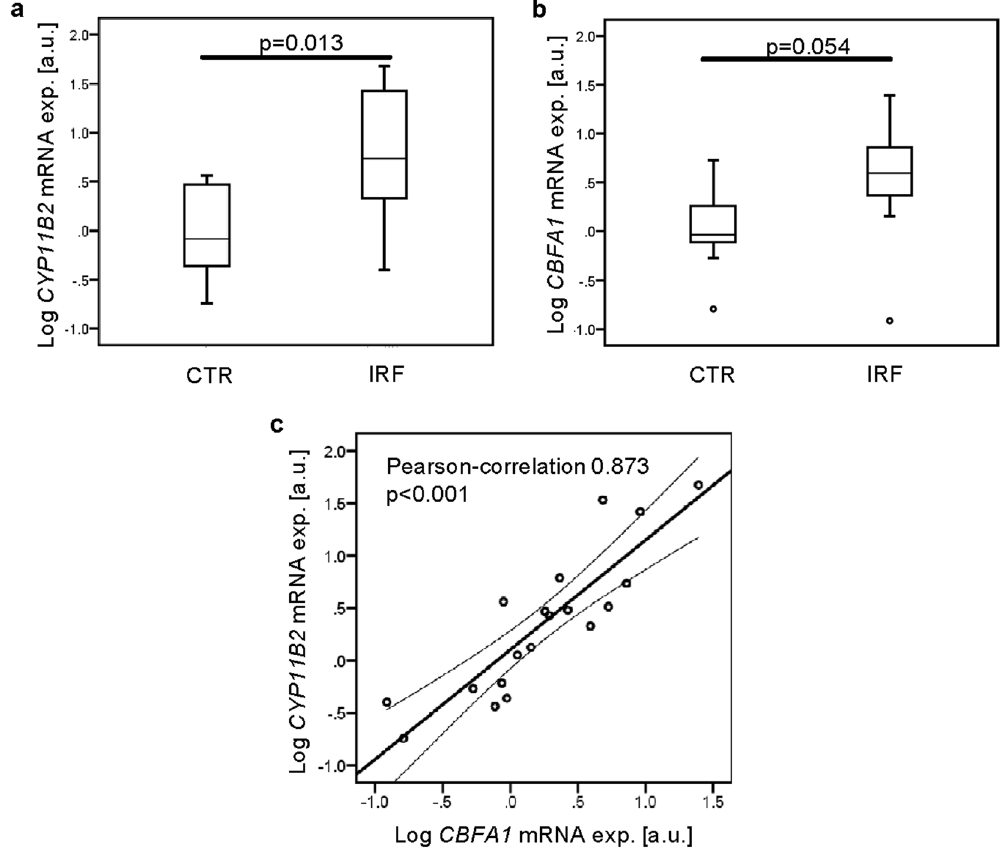
Figure 8. Aldosterone synthase and CBFA1 expression in human coronary arteries. Boxplots of log- transformed CYP11B2 ( a , arbitrary units, a.u.) and CBFA1 ( b , a.u.) relative mRNA expression in right coronary artery tissue from patients with maintained (CTR, n = 10) and impaired (IRF, n = 9) renal function. ( c ) Association of log-transformed CYP11B2 (a.u.) and CBFA1 (a.u.) relative mRNA expression in right coronary artery tissue from patients with maintained (n = 10) and impaired (n = 9) renal function. P values are indicated in the